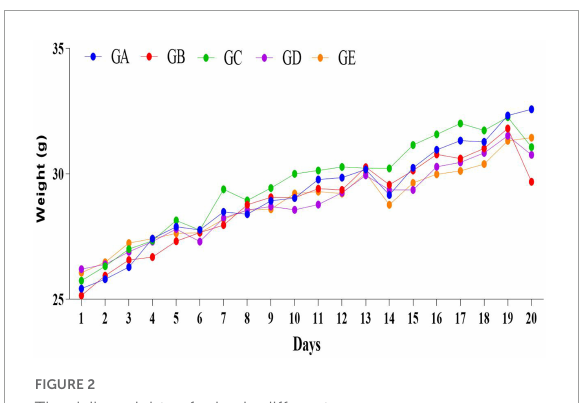
FIGURE2 The daily weights of mice in different groups.